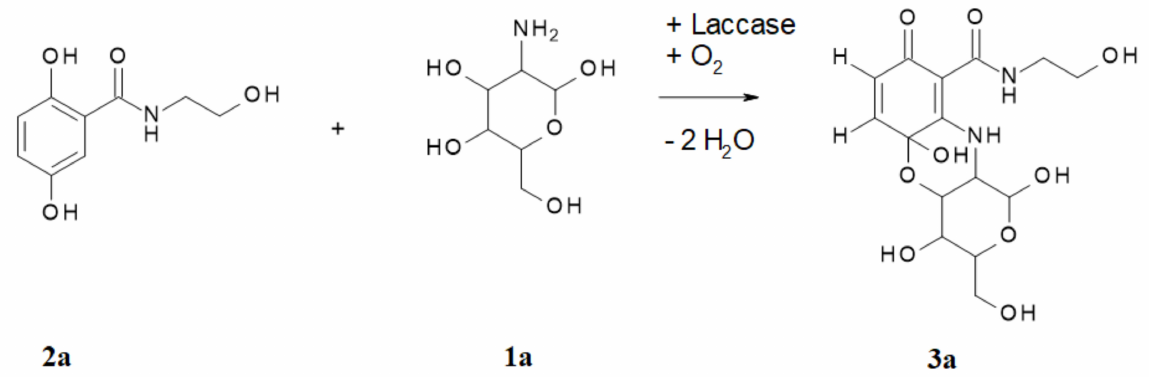
Figure 2. Laccase-catalyzed reaction of 2,5-dihydroxy- N -(2-hydroxyethyl)-benzamide ( 2a ) with glucosamine ( 1a ) for the synthesis of the product 3a .